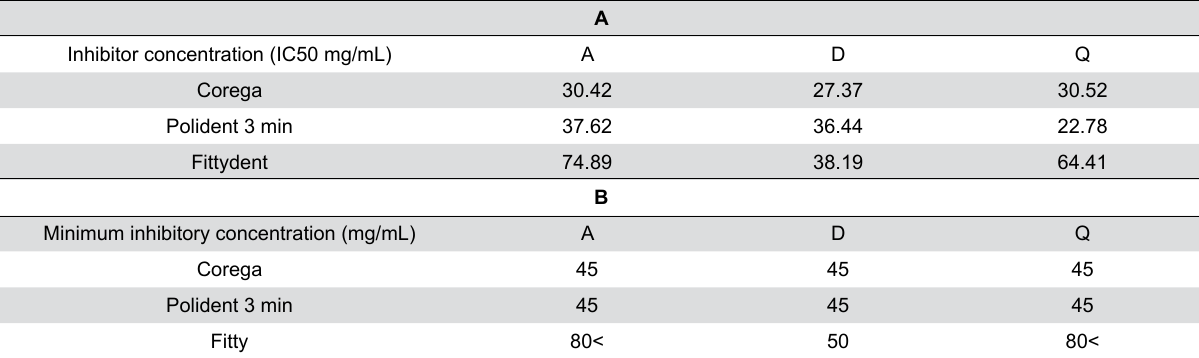
Figure 2- The effects of Corega, Polident 3 min or Fittydent tablets on the viability of Candida albicans biofilm on the surface A-, Q-, or D-type resin specimens. Exponentially growing cells on denture surface were incubated with Corega, Polident 3 min or Fittydent cleansing solutions for 5, 3, and 5 min, respectively, and the cell viability was measured by the MTT assay. Percent viability was reported as mean values±SEM of three independent assays (p<.05) Table 1- A) IC50 values for Corega, Polident 3 min or Fittydent cleansing tablets. B) MIC values for Corega, Polident 3 min or Fittydent cleansing